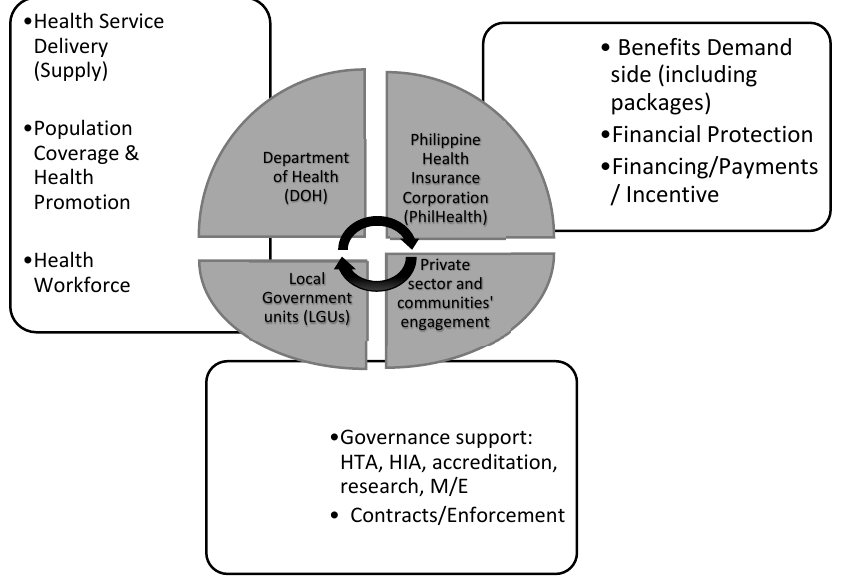
Figure 1. Framework of the Content Study on the Philippine UHC Act.